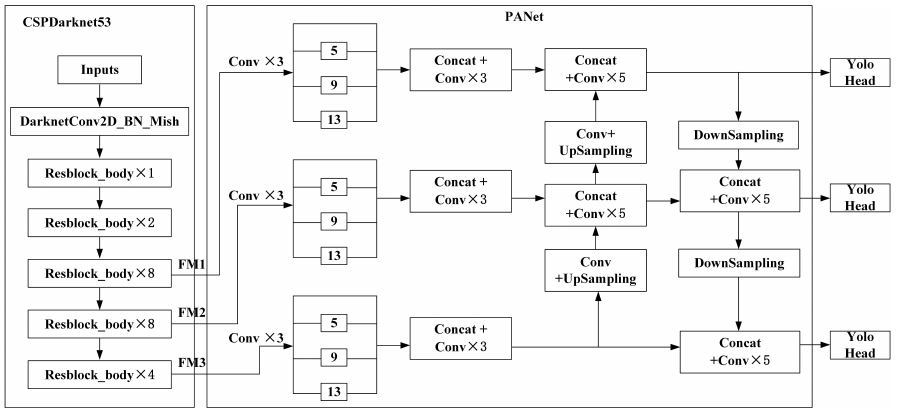
Figure 1. Improved YOLOv4 neural network architecture. Three feature maps (FPs) of different scales are extracted from the backbone, which are denoted as FM1, FM2, and FM3, with sizes of 13 × 13, 26 × 26, and 52 × 52. All three feature maps run through 3 convolutional operations before being fed into the SPP